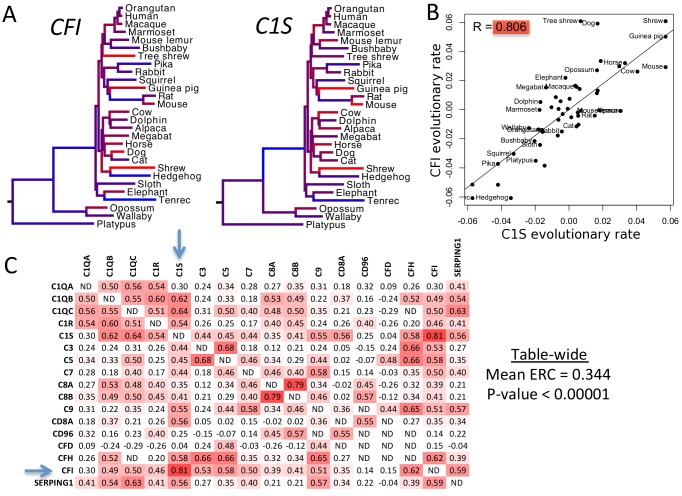
ERC values between complement deficiency genes.A) Complement genes C1S and CFI show variation in their evolutionary rates between branches of the mammalian phylogeny. Branches are color-coded according to rate. (Red is for rapid evolution, blue for slow, and intermediate shades for rates in between.) Tree topology and distances between species are the same for each gene. B) The same evolutionary rates for C1S and CFI are plotted against each other. Their correlation is apparent here in the best-fit line and correlation coefficient of 0.806. C) This matrix contains all pairwise ERC values between the OMIM genes for complement deficiency. Cells are shaded red according to the intensity of their departure from the null expectation. Blue arrows indicate the genes C1S and CFI. It is notable that most values are positive, whereas a random collection of genes would contain equal proportions of positive and negative values. There are also many clusters of functionally related complement proteins that contain very strong signals of ERC. The C1-related proteins in the upper left corner are a prime example of such an ERC hotspot.